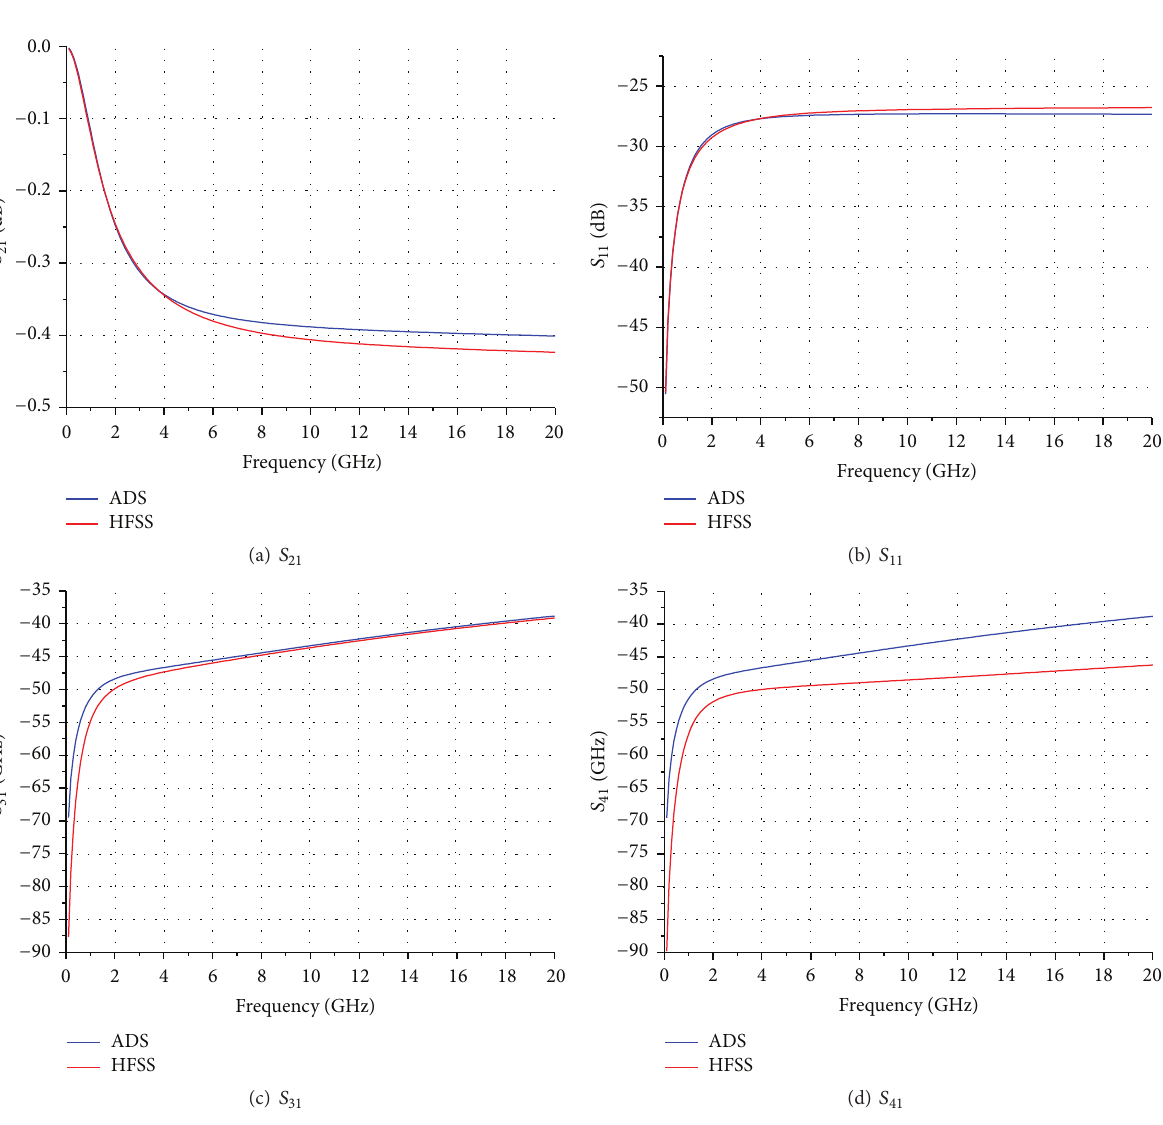
Figure 5: Simulation results in HFSS and